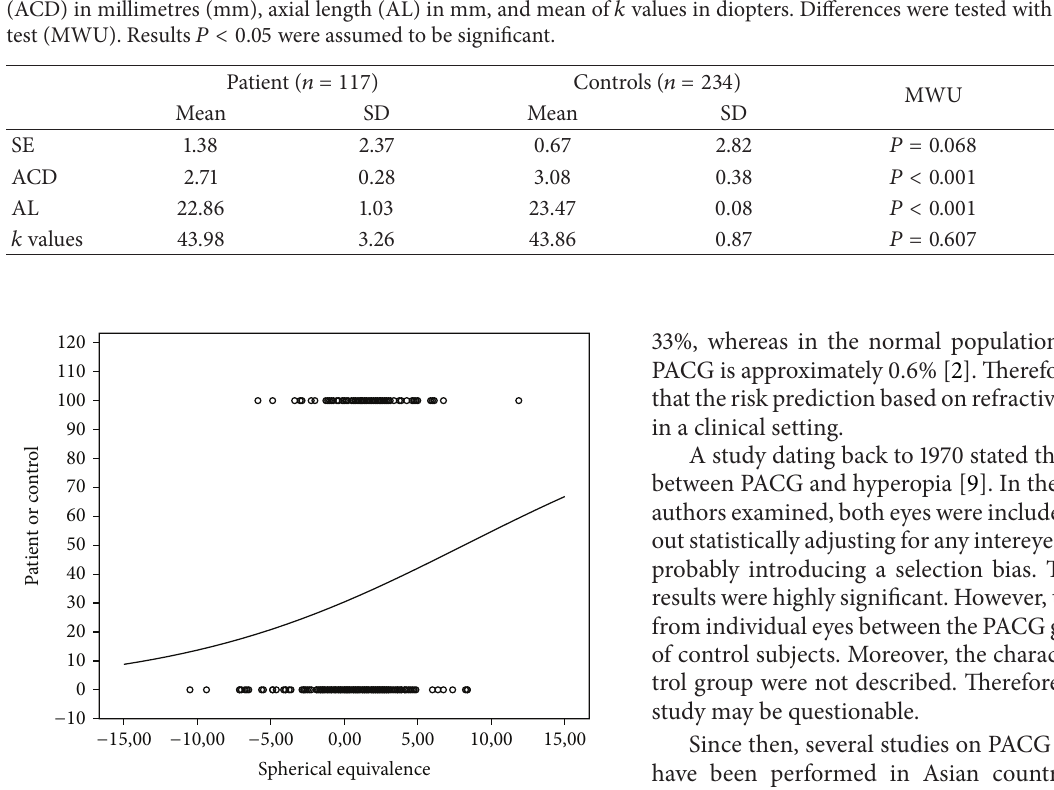
Figure 2: Distribution of spherical equivalent (in dioptres) among patients ( 𝑦 = 100 ) and controls eyes ( 𝑦 = 0 ). The curve represents the risk prediction of PACG based on spherical equivalent refractive